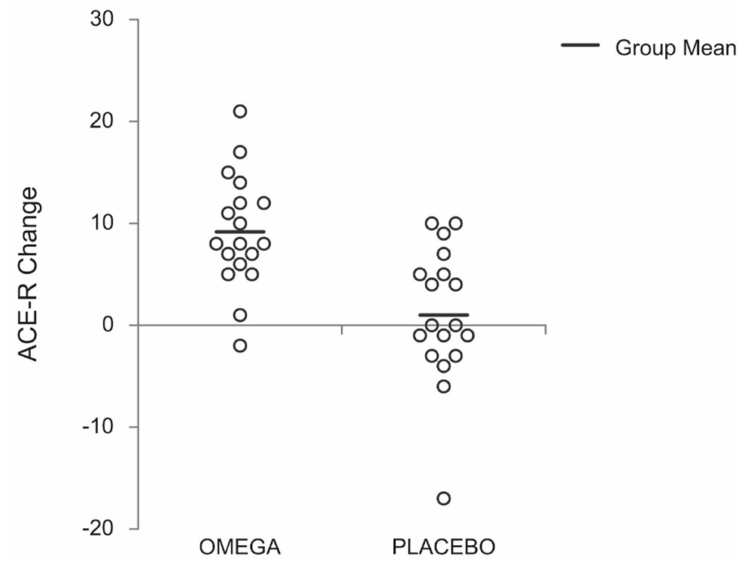
Figure 2. Individual Addenbrooke’s Cognitive Examination -Revised (ACE-R) change (pre-post) for each